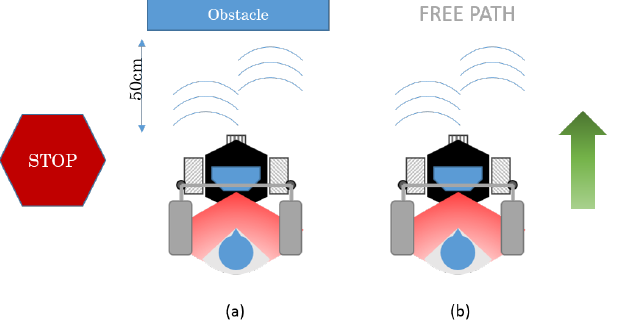
Figure 17. Ultrasound sensors are used to avoid collision. In ( a ), it stops moving to avoid the obstacle; in ( b ), it keeps moving, since there is no